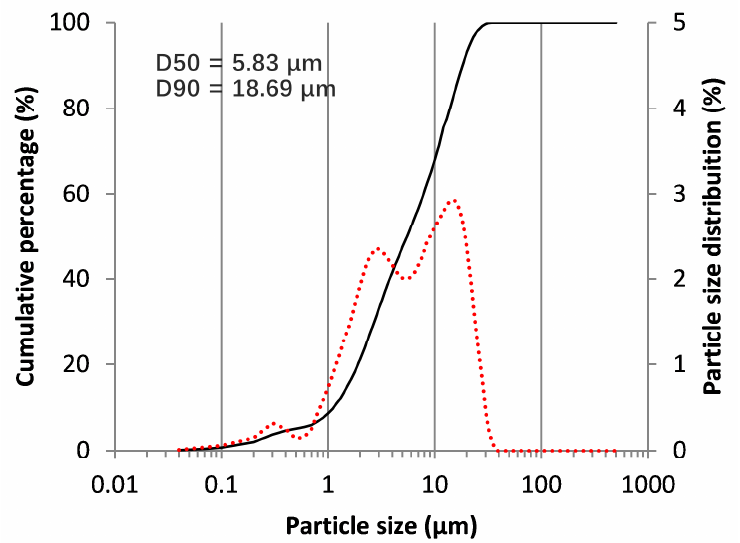
Figure 1. Particle size distribution of the BOF slag.